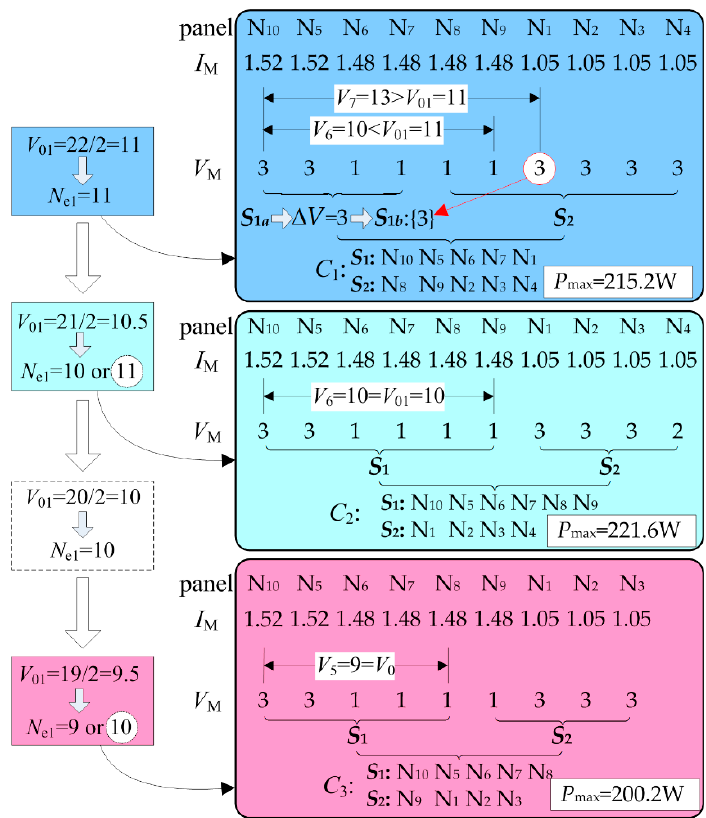
Figure 10 . Determination of possible configurations in Case 1. Figure 10. Determination of possible configurations in Case